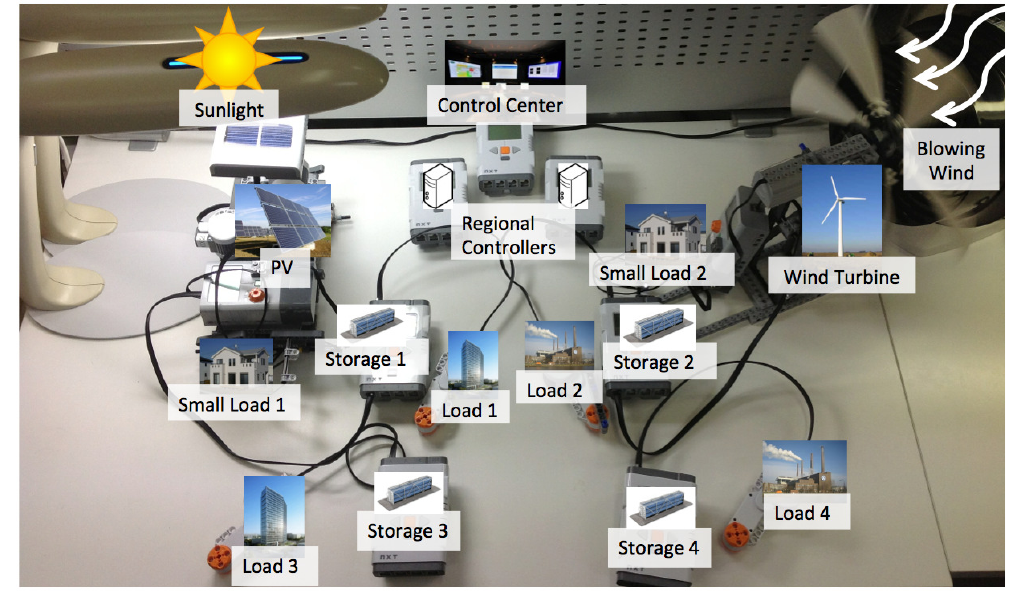
Figure 18. Overview of the miniature microgrid for the demonstrated